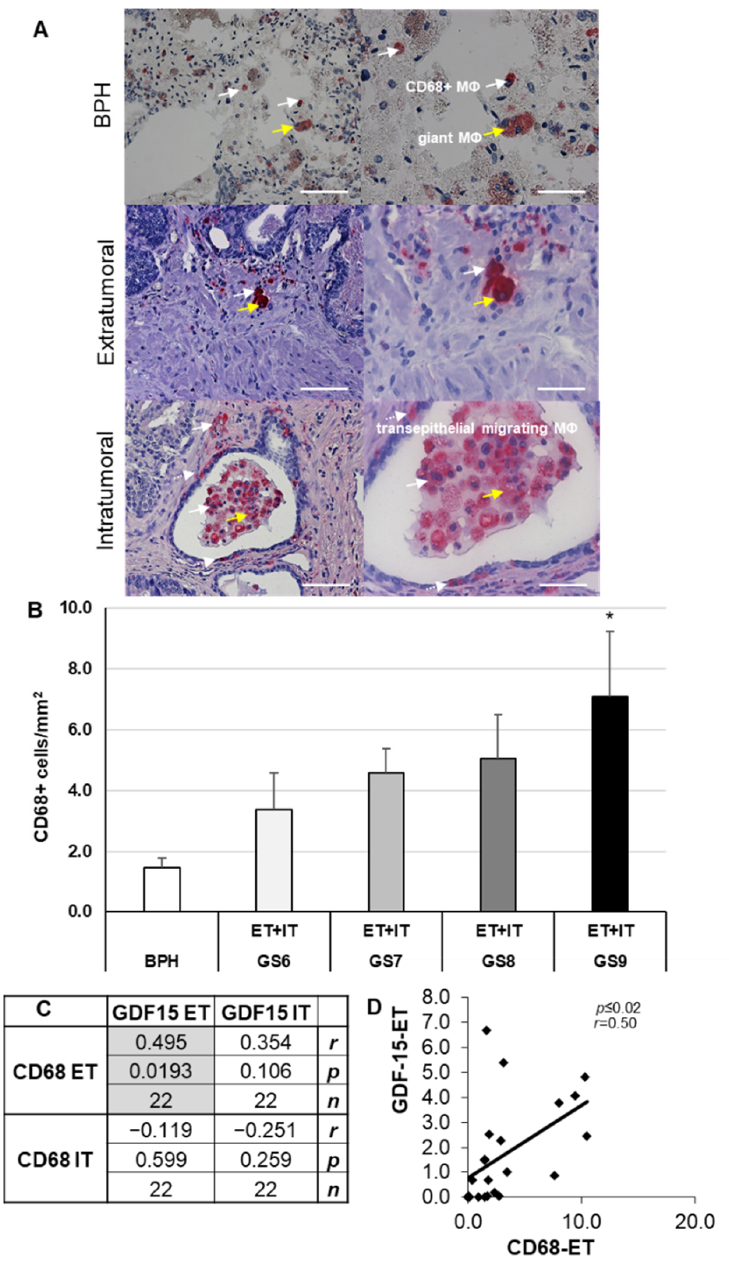
Figure 3. CD68+ M Φ IHC of human BPH and PCa. ( A ) Representative images of CD68+ M Φ in BPH and extratumoral [ET] or intratumoral [IT] PCa regions; CD68+ M Φ are marked with white arrows; multinucleated M Φ are marked with yellow arrows, and transepithelial migrating M Φ are indicated with white dotted arrows. ( B ) Density of CD68+ M Φ in BPH and PCa with different Gleason scores (GS). ( C , D ) Pearson’s correlation coefficient, significant correlation was marked with gray. The data show means + SEM; significance: * p ≤ 0.05 vs. BPH. Scale bars: left column 200 µ m, right column 100 µ m. Pearson product moment correlation between ET and IT of CD68+ and GDF-15+ ( C , D ). Correlation coefficient ( r ), p- value ( p ) and the number of samples ( n ). The density of CD163+ M Φ in the ET regions of the PCa correlated significantly ( p ≤ 0.04) positively ( r = 0.45) with the density of GDF-15+ cells in the ET region (Figure 4C,D). However, the density of CD163+ M Φ ET or CD163+ IT did neither correlate with the density of GDF-15+ IT, nor did the density of CD163+ M Φ IT correlate with the density of